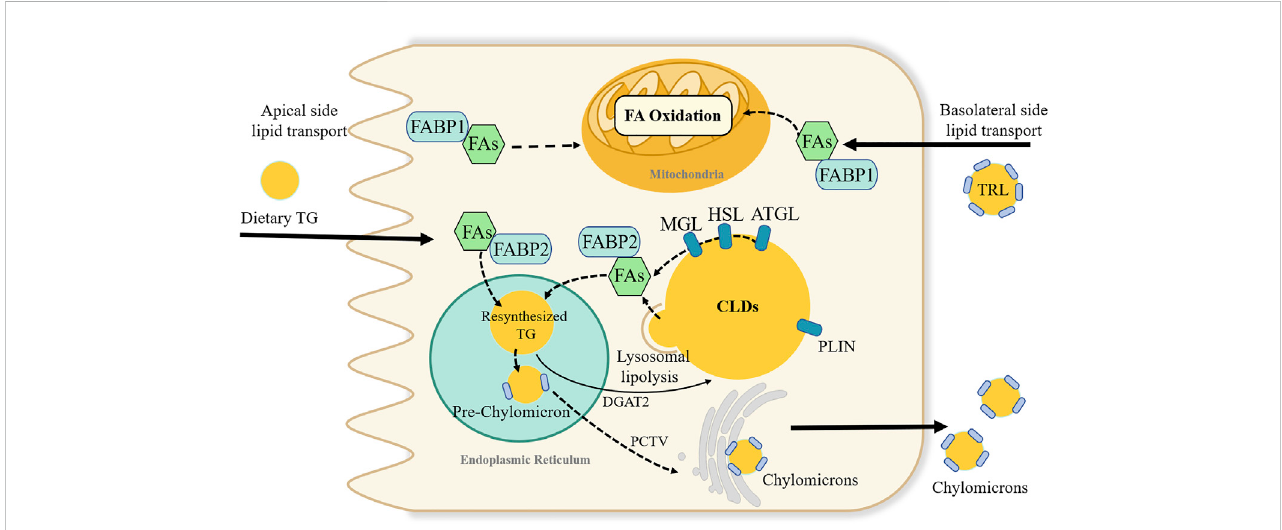
FIGURE 3 Dynamic lipids pool and proposed fatty acids metabolic fate in intestinal enterocyte. Fatty acids (FAs) in enterocytes can source from the apical side of enterocytes or the basolateral side. FAs absorbed from the intestinal lumen preferentially direct the triglyceride (TG) synthesis and undergoes secretion into lymph inchylomicrons.While, FAsfrom thecirculatorysystem,i.e.,basolateralsidesourceofFAs arepre-utilizedfor phospholipid synthesis andFA oxidation. FAsbindingtofattyacid-bindingprotein1issuggestedtotransportedFAstowardstheFAoxidationpathway.Manyproteinslikeperilipinfamilyinvolvein the stabilizing and swelling of cytoplasmic lipid droplets (CLDs) TG stored in CLDs can be break down by a series of lipases, or through lysosomal lipolysis pathway. Adipocyte triglyceride lipase (ATGL), hormone sensitive lipase (HSL) and monoacylglycerol lipase (MGL); diacylglycerol acyltransferase (DGAT2); PCTV; triglyceride-rich lipoproteins (TRL); perilipin